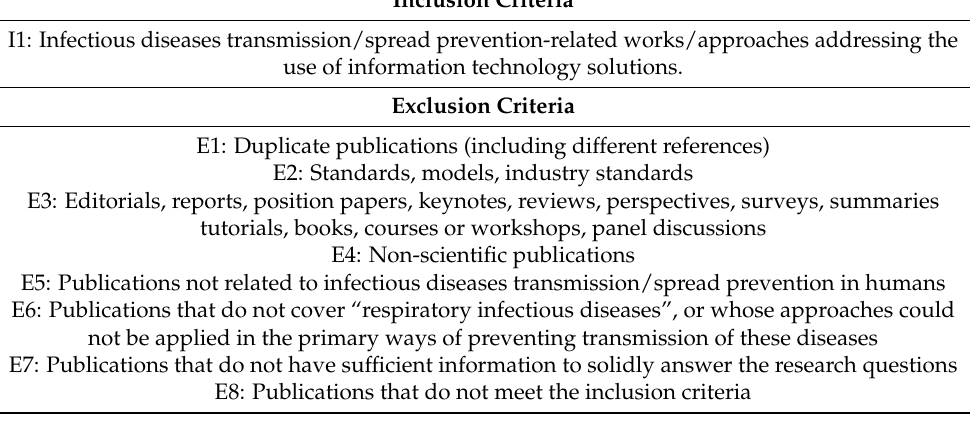
Table 3. Adopted inclusion and exclusion criteria.